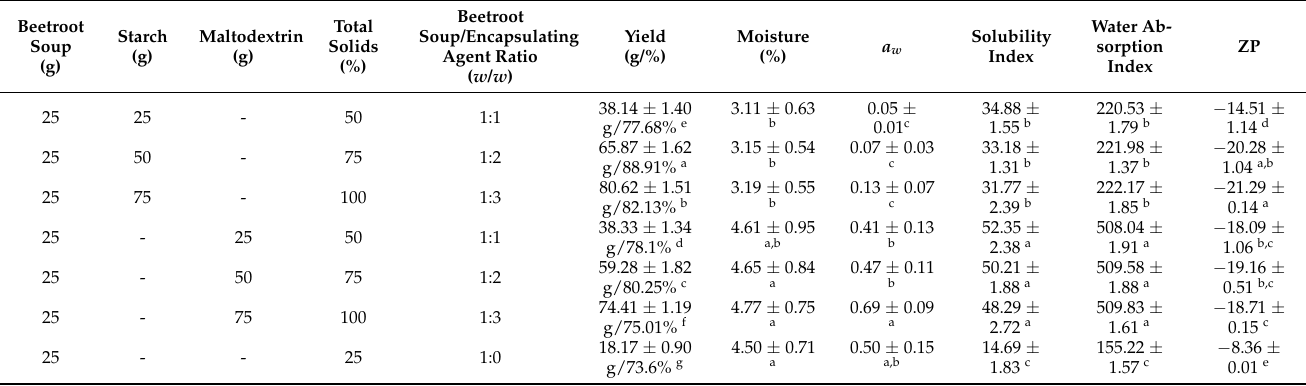
Values are expressed as means ± SD. Different letters in the same column indicate statistically significant differences between samples ( p < 0.05). a w , water activity; ZP, zeta potential. Beetroot soup with an encapsulating matrix/nucleus ratio of 1:0 does not contain encapsulating agent (pure beetroot soup). The moisture of beetroot soup microparticles ranged from 3.11 ± 0.43 to 3.19 ± 0.55% in starch, and from 4.61 ± 0.95 to 4.77 ± 0.75% in maltodextrin. The microparticle moisture in starch was lower than in maltodextrin and when no encapsulating agent was added, indicating a possible technological improvement in the shelf life and overall stability of the beetroot soup product (Table 2). Furthermore, beetroot soup microparticles presented low a w , ≤ 0.55 for beetroot soups without encapsulant agents and ≤ 0.15 and ≤ 0.50 microen- capsulated in starch and maltodextrin, respectively, with the exception of the 1:3 ( w / w ) ratio in maltodextrin, which reached <0.69 (Table 2). The water solubilities of